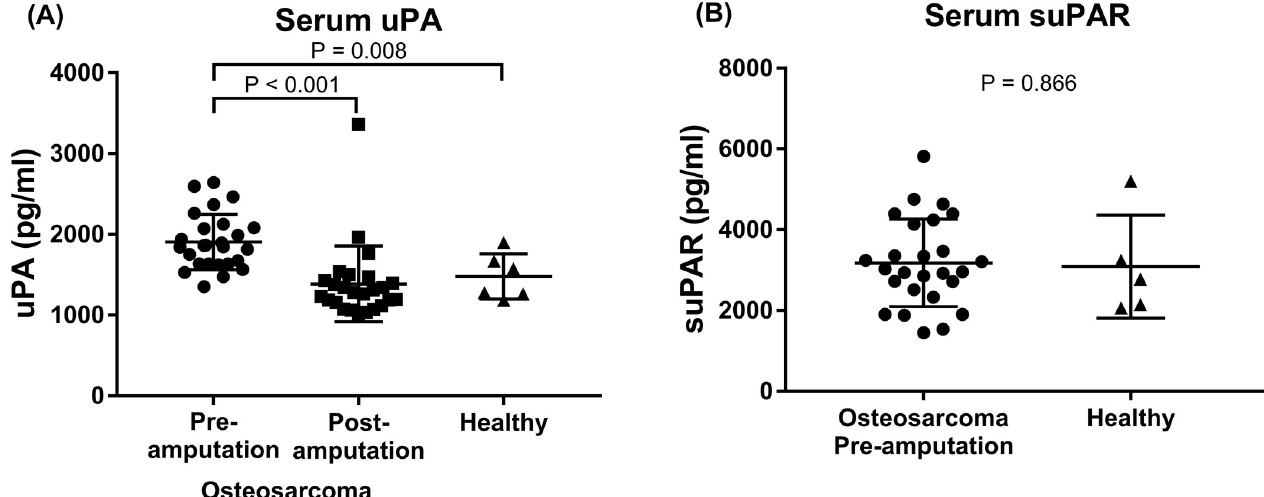
Fig 1. Serum uPA and suPAR levels of osteosarcoma-bearing and clinically healthy dogs. Serum uPA (A) and suPAR (B) levels were analyzed using commercially available canine uPA and uPAR ELISA kits, respectively. (A) Dogs with osteosarcoma had higher presurgical serum uPA level (n = 26) than clinically healthy dogs (n = 6; p = 0.008) and the level decreased postoperatively (n = 25; P < 0.001). (B) There was no difference in suPAR level between dogs with osteosarcoma pre-amputation (n = 26) and healthy control dogs (n = 5; p = 0.866). Serum suPAR level was not measured in the post-amputation samples, given the lack of difference between the osteosarcoma-bearing and healthy dogs at baseline. The error bars show standard